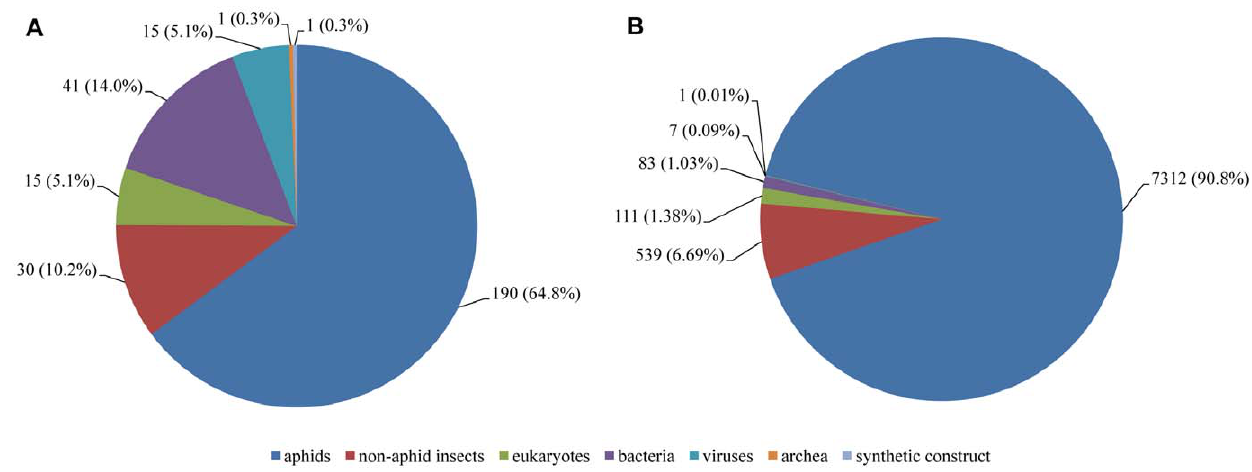
Figure 2. Species distribution of top BLASTx matches of Aphisglycines sequences. Species distribution of the top BLASTx matches of the transcripts of A. glycines B1 (A) and reduced representation genome of A. glycines B2 (B). The percentages were calculated considering the total number of sequences with BLASTx hits as 100%.